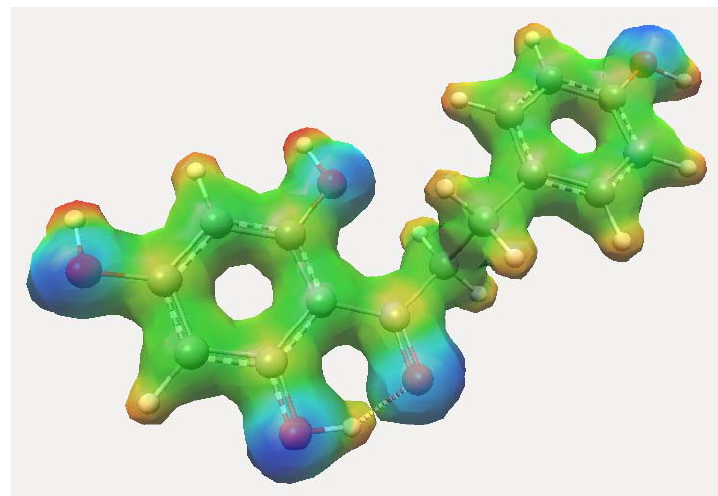
Figure 4. MEPs of dihydrochalcone derivative IX